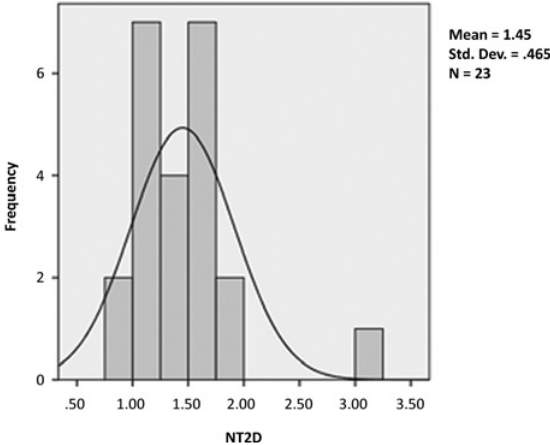
Fig. 4 - Histogram of two dimensional ultrasound nuchal translucency thicknesses distributions.